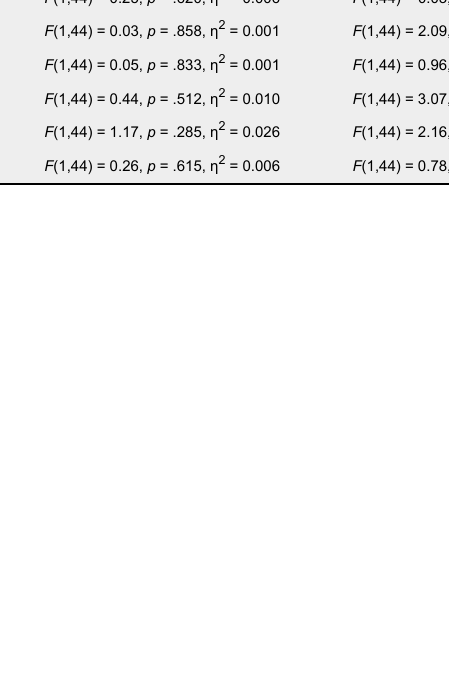
Figure 5. Interaction between time and group for percentage of correct responses in the Arabic number comparison task. Error bars represent standard